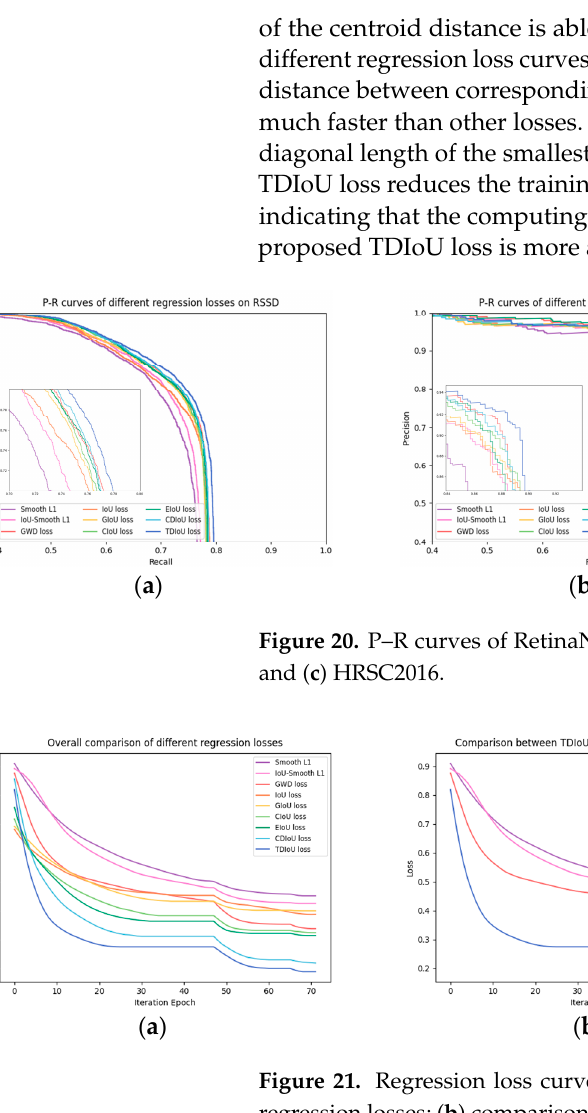
Table 7. Comparison of different feature fusion networks on RSSD. The structure of all feature fu- sion networks is used only once in our experiment. Here, ADD represents the direct addition of feature maps, while LWF indicates the linear weighted fusion method in BiFPN [27].